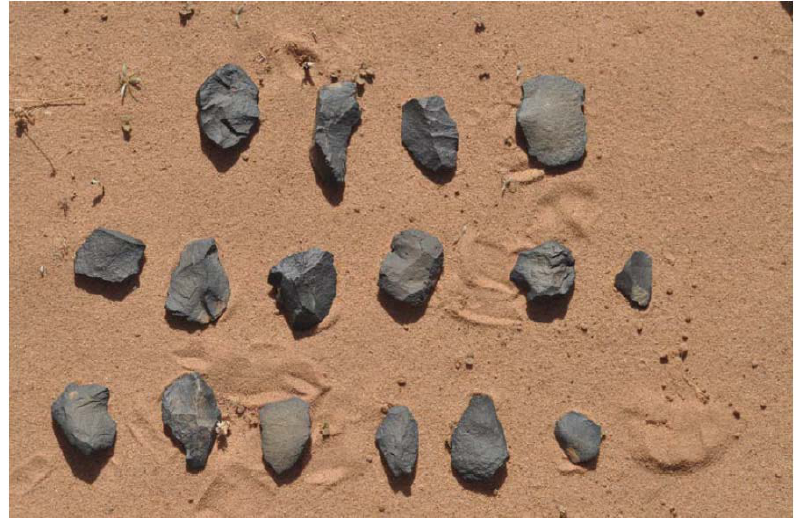
Figure 22. Stone objects from Shuwaymis.